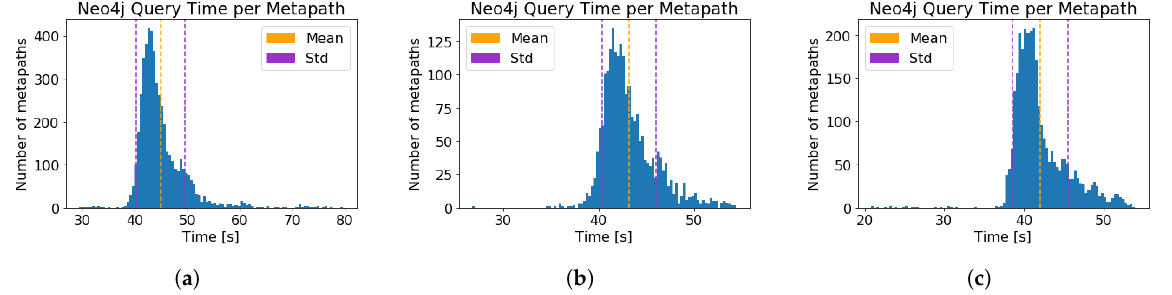
Figure 4. Distribution of Neo4j query times in SemNet version 1 HeteSim computation for all metapaths joining the given source node and Alzheimer’s disease. ( a ) Insulin; ( b ) Hypothyroidism; ( c )